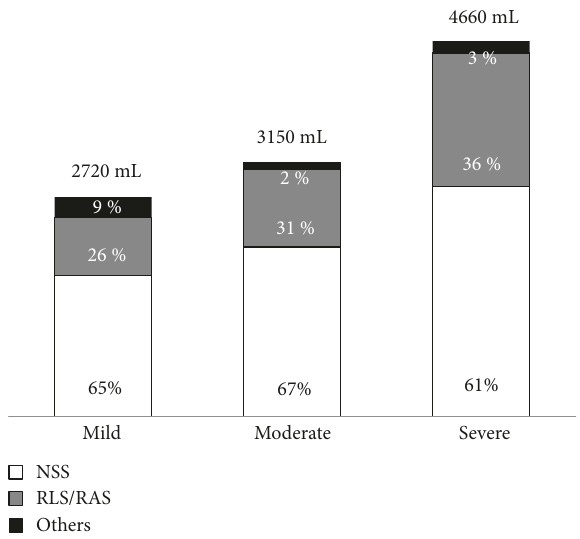
Figure 2: Types and amounts of intravenous fl uid therapy during the fi rst 24 hours. NSS, normal saline solution; RLS/RAS, Ringer ’ s lactate solution/Ringer ’ s acetate solution.